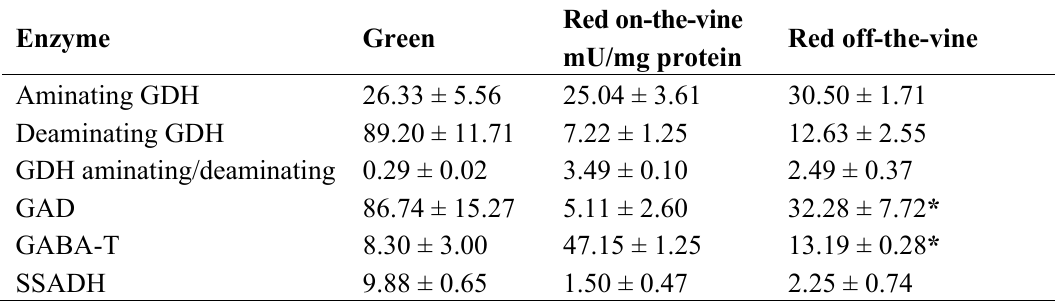
Table 2. Enzyme activities in mature green and red fruits ripened on- and off-the-vine. One U is the amount of enzyme which catalyzes the transformation of 1  mol of substrate per min. Results are presented as means of three independent experiments ±